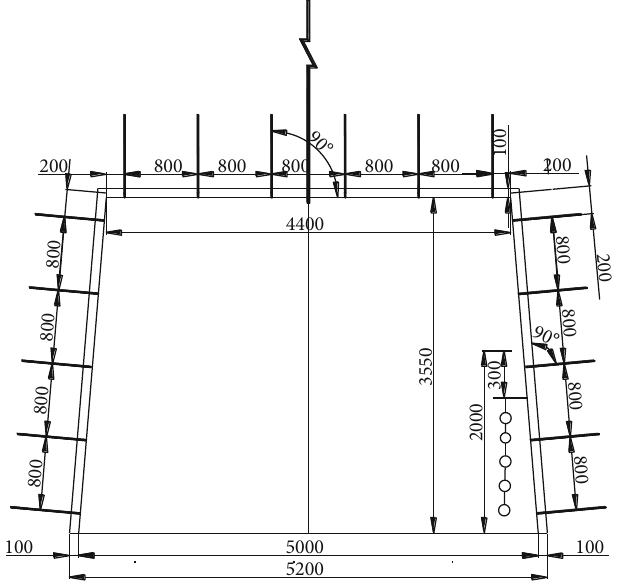
Figure 4: Roadway cross sections of the gob-side entry